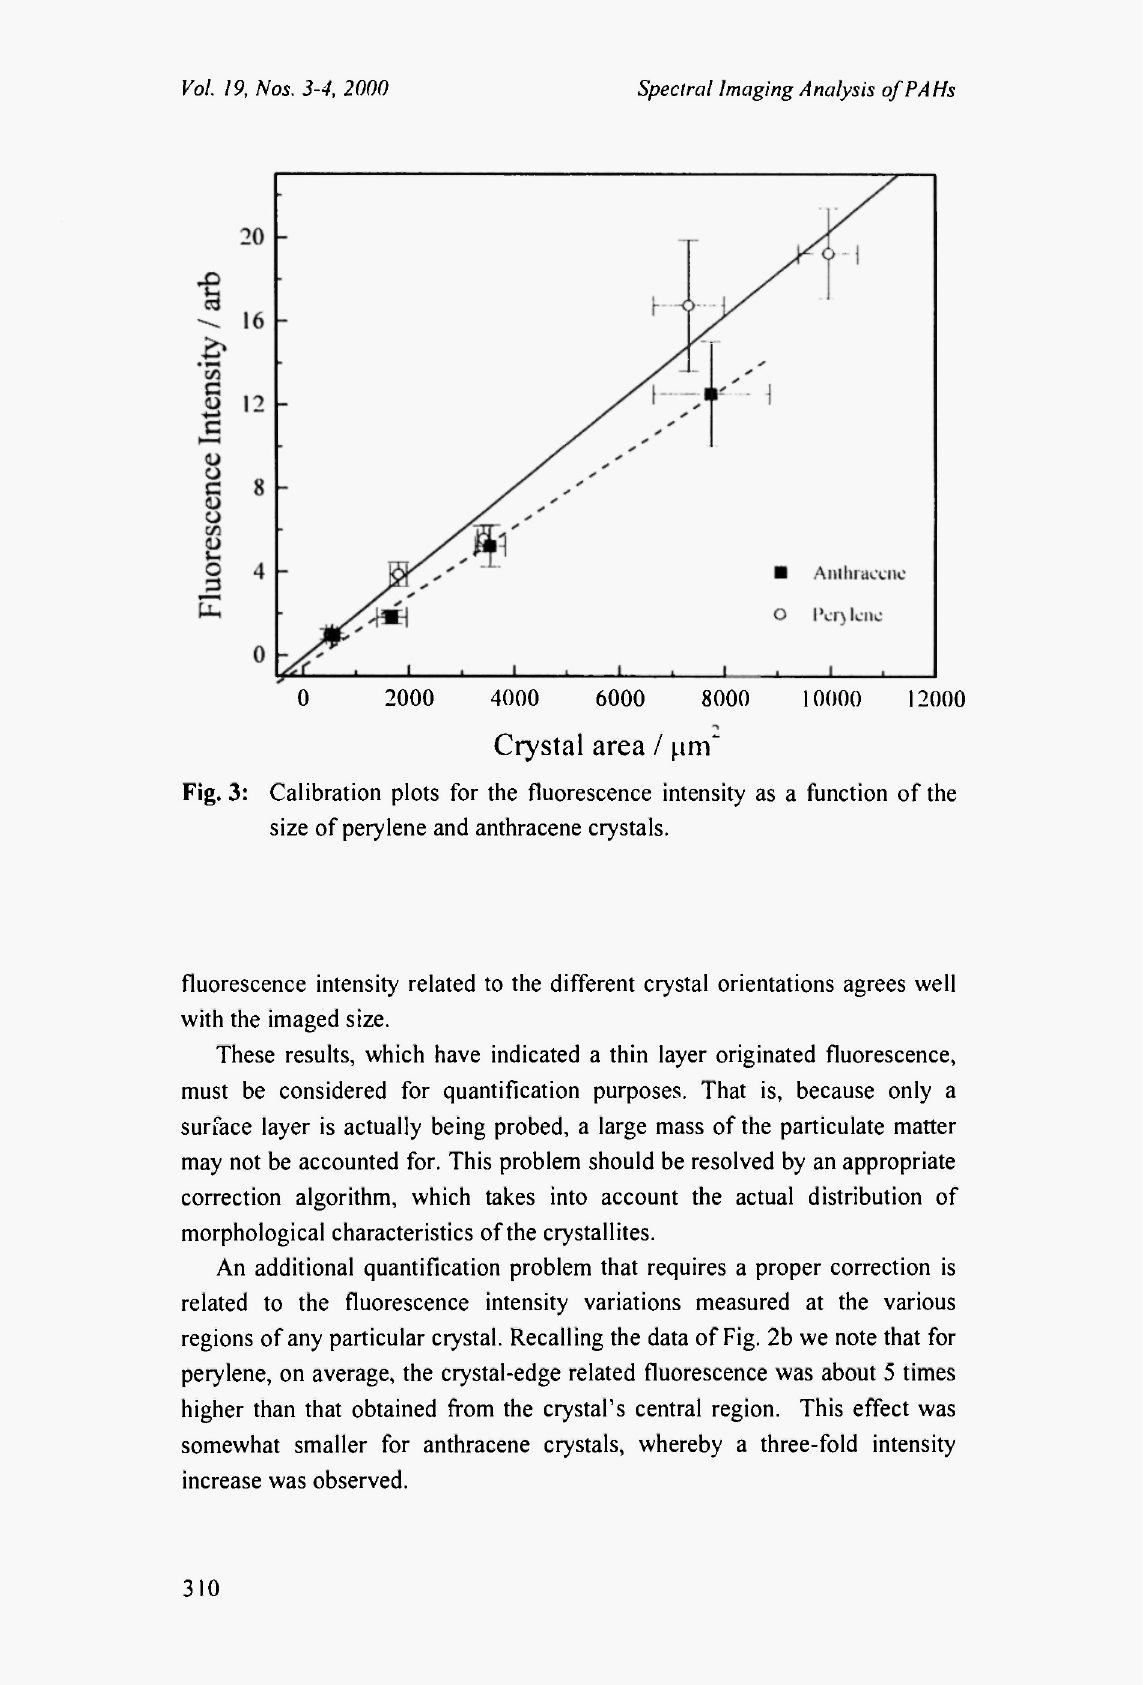
Fig. 3: Calibration plots for the fluorescence intensity as a function of the size of perylene and anthracene